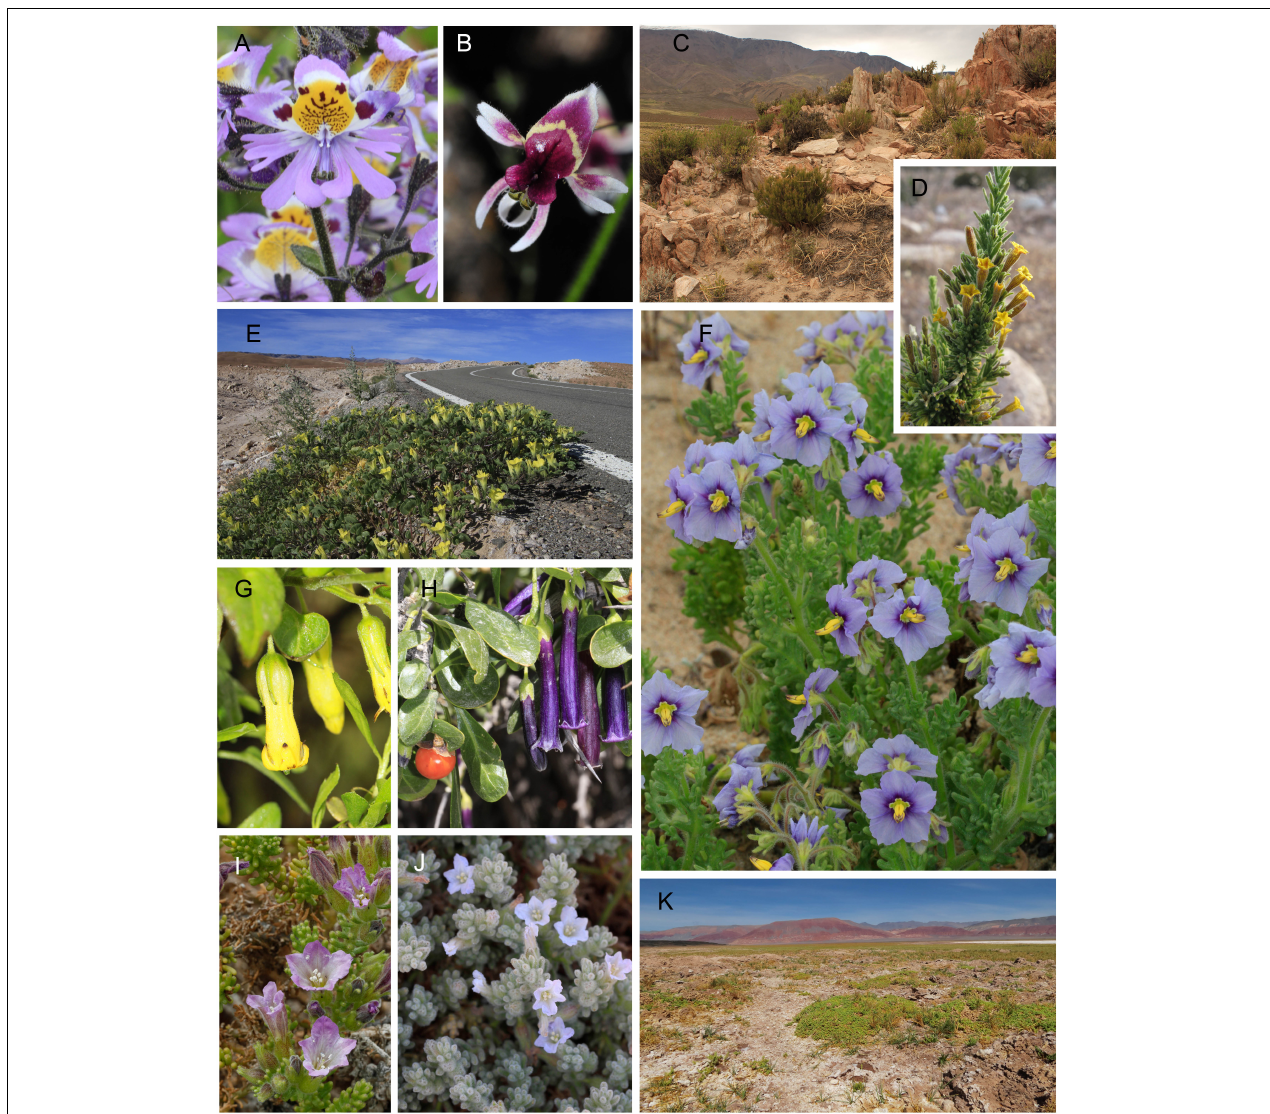
FIGURE 1 | Floral morphology and habitat diversity of southern Solanaceae. (A) Schizanthus porrigens and (B) Schizanthus parvula from Central Chile; (C) Fabiana denudata in Catamarca, Argentina; (D) Fabiana ramulosa in Chilean Altiplano; (E) Exodeconus flavus in Tarapacá Precordillera, north Chile; (F) Solanum trinominum in Chilean coastal sand dunes; (G) Salpichroa glandulosa and (H) Dunalia spinosa in the heights of Parinacota, Chile; (I,J) Nolana mollis and N. villosa on the lomas formation, Chile; (K) Lycium humile on salt-rich environments of the Altiplano highlands. Photographs by M. Virginia Palchetti, Rocío Deanna, and Andrés